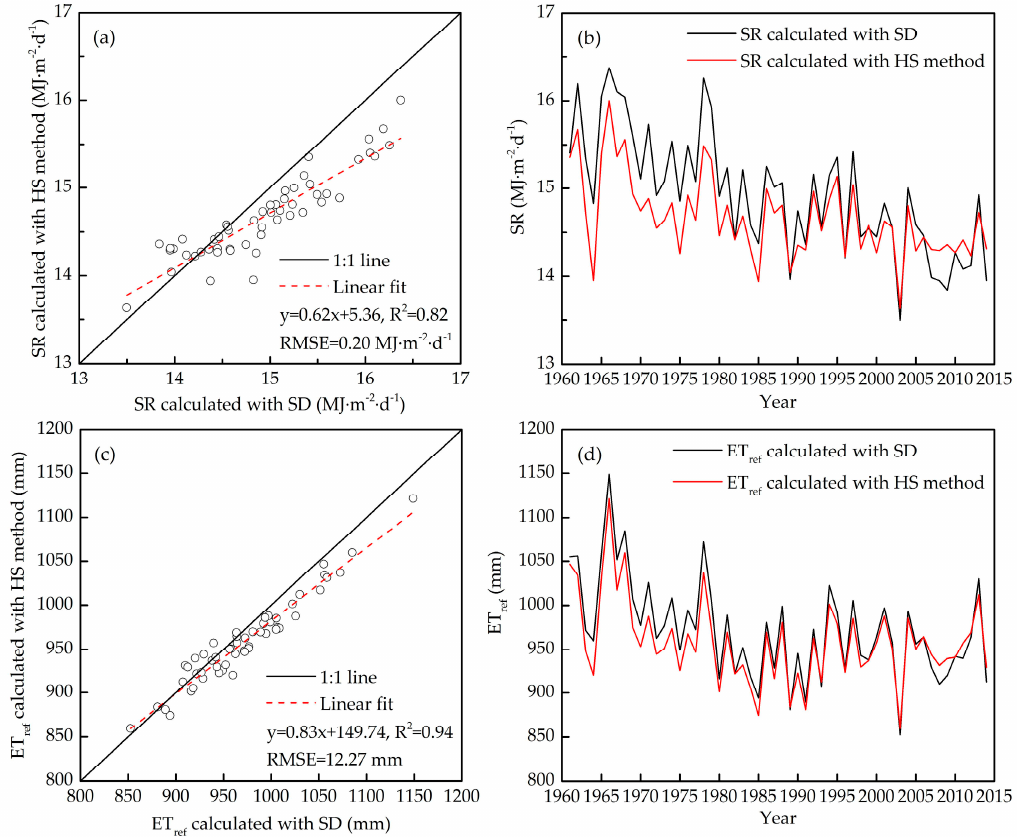
Figure A1. The fitting precision of the SR_HS ( SR calculated with Hargreaves–Samani method), compared with the SR_SD ( SR calculated with SD ), and the fitting precision of ET ref _HS ( ET ref calculated with Hargreaves–Samani method) compared with the ET ref _SD ( ET ref calculated with SD ).